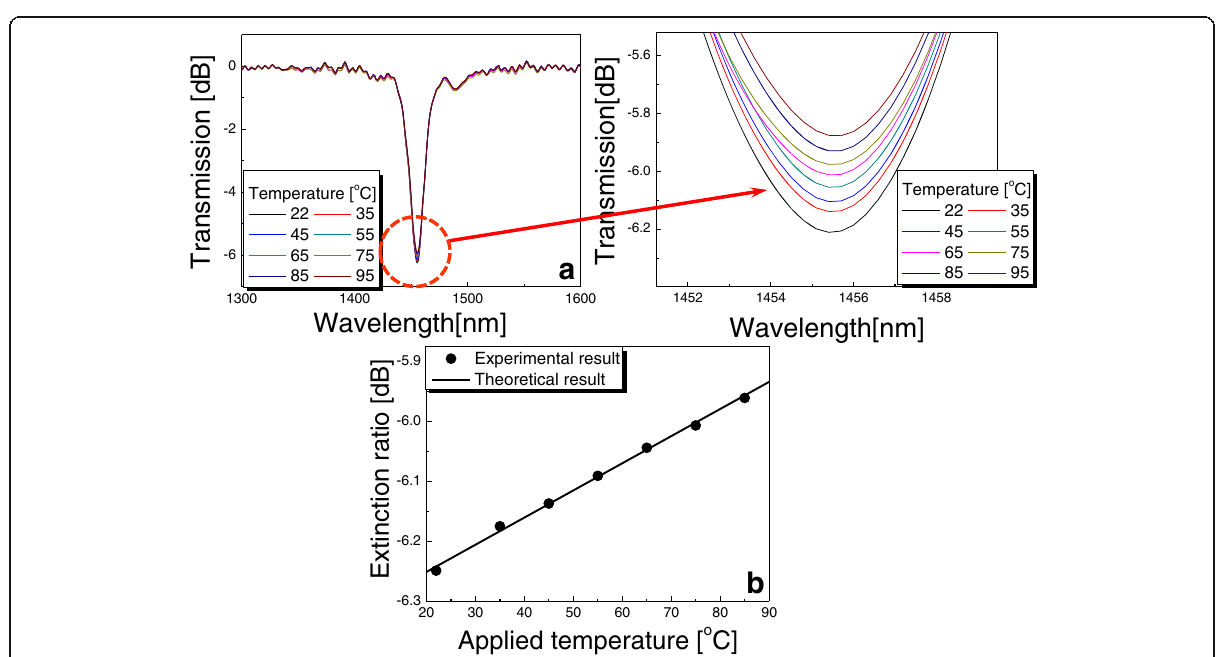
Fig. 5 a Transmission spectra with variations in temperature. b Variation of extinction ratio as a function of temperature